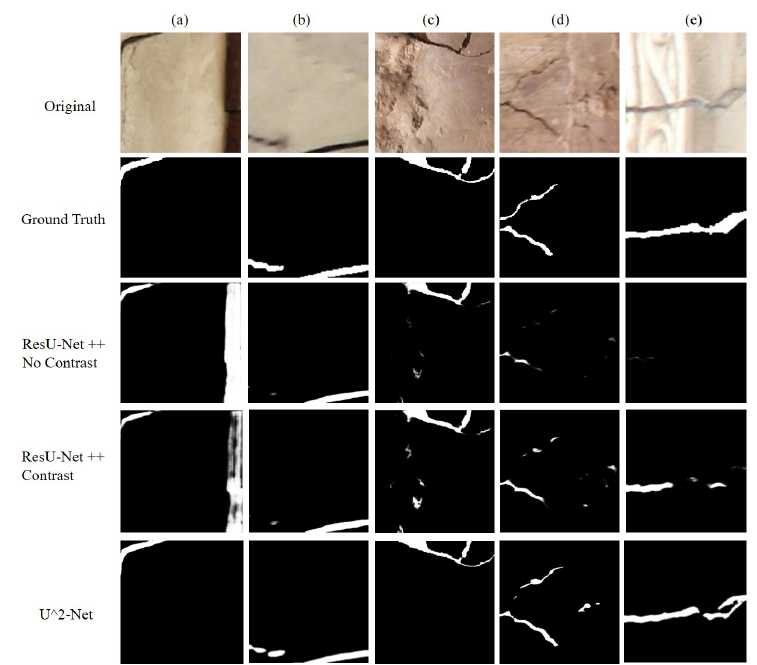
Figure 14. Results on several samples of the used crack detection dataset, with different patterns— group-3. In each column, we present the results based on: ( a ) Image with a short wide crack on the edge, ( b ) Wide crack on the edge, ( c ) Image with a crack and corrosion, ( d ) Blurred image with a crack, ( e ) Blurred image with a crack inside ornaments.